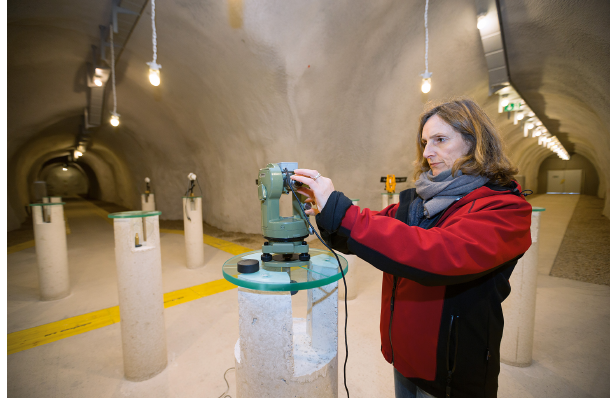
Figure 8. Manual control of automatic measurements of the geo- magnetic field taken at the Conrad Observatory – GMO (ZAMG,